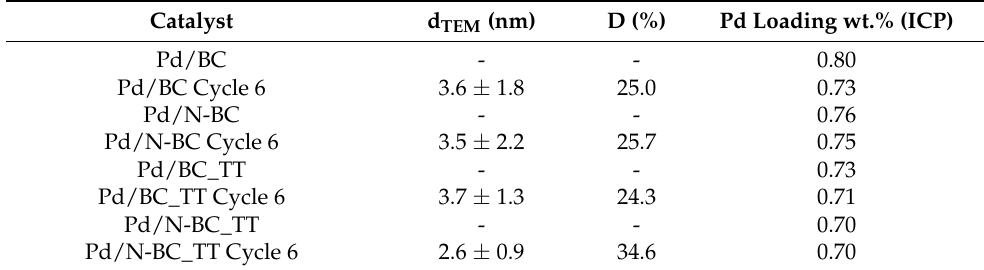
Figure 6. TEM micrographs for catalyst fresh and used after six cycles, and histograms with Pd nanoparticle size distributions for the used catalysts. Table 3. Results of TEM and ICP